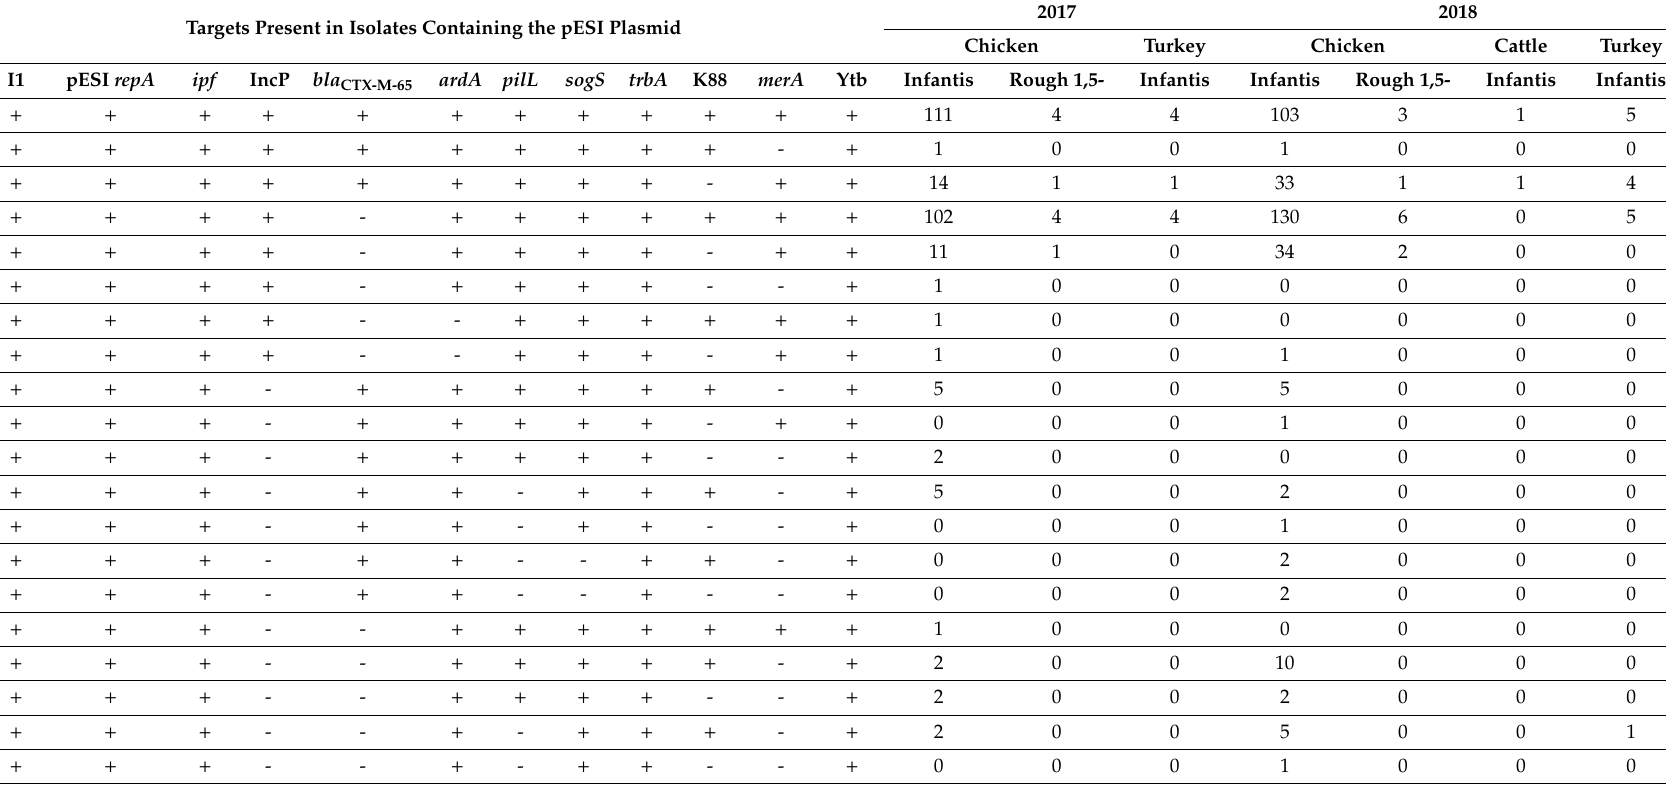
Table 2. pESI target profiles of isolates collect by United States Department of Agriculture-Food Safety and Inspection Service Hazard Analysis and Critical Control Point sampling. Plus indicates present, minus indicates